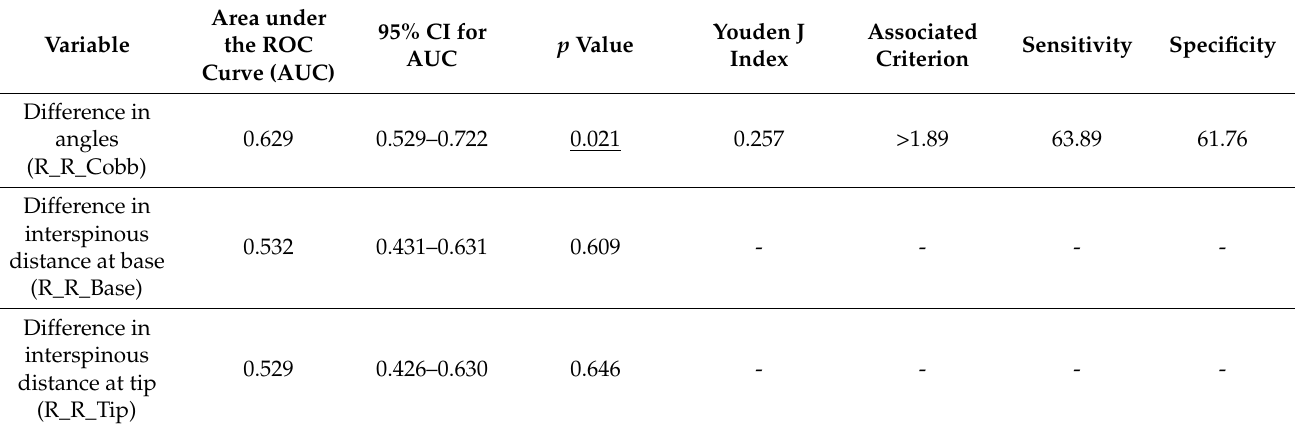
Table 3. Receiver operating characteristics (ROC) curve analyses for the reference method and parameters based on differences between flexion and extension measured before and 12 months after the surgical